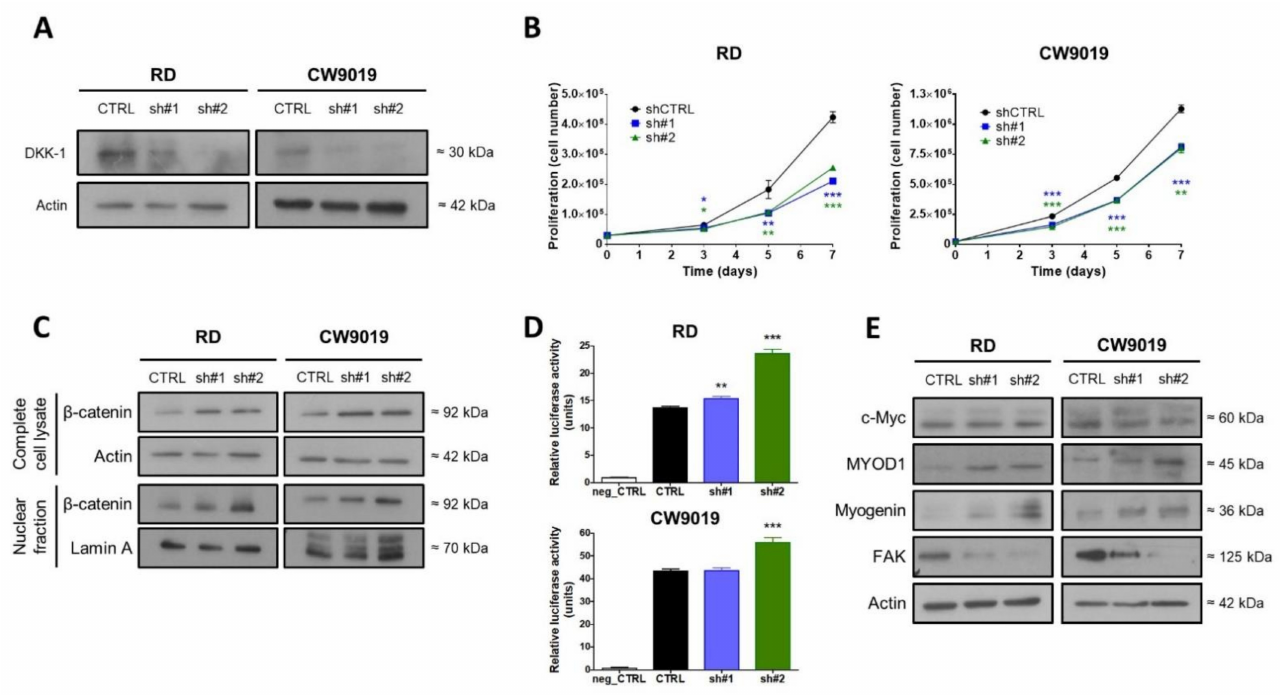
Figure 2. Analysis of DKK-1 genetic inhibition by shRNA. ( A ) Two shRNAs against DKK-1 (sh#1 and sh#2) were selected once the inhibition at the protein level was confirmed in two RMS cell lines. ( B ) The proliferation assay was carried out for 7 days in RD and CW9019 cell lines. ( C ) Activation of the Wnt signaling pathway after DKK-1 inhibition was analyzed by determination of β -catenin protein levels by WB in complete cell lysate and nuclear fraction, and by ( D ) β -catenin promoter activity using the TOPFlash system. In ( E ), the protein level of different specific markers was determined by WB. * p < 0.05, ** p < 0.01 and *** p <